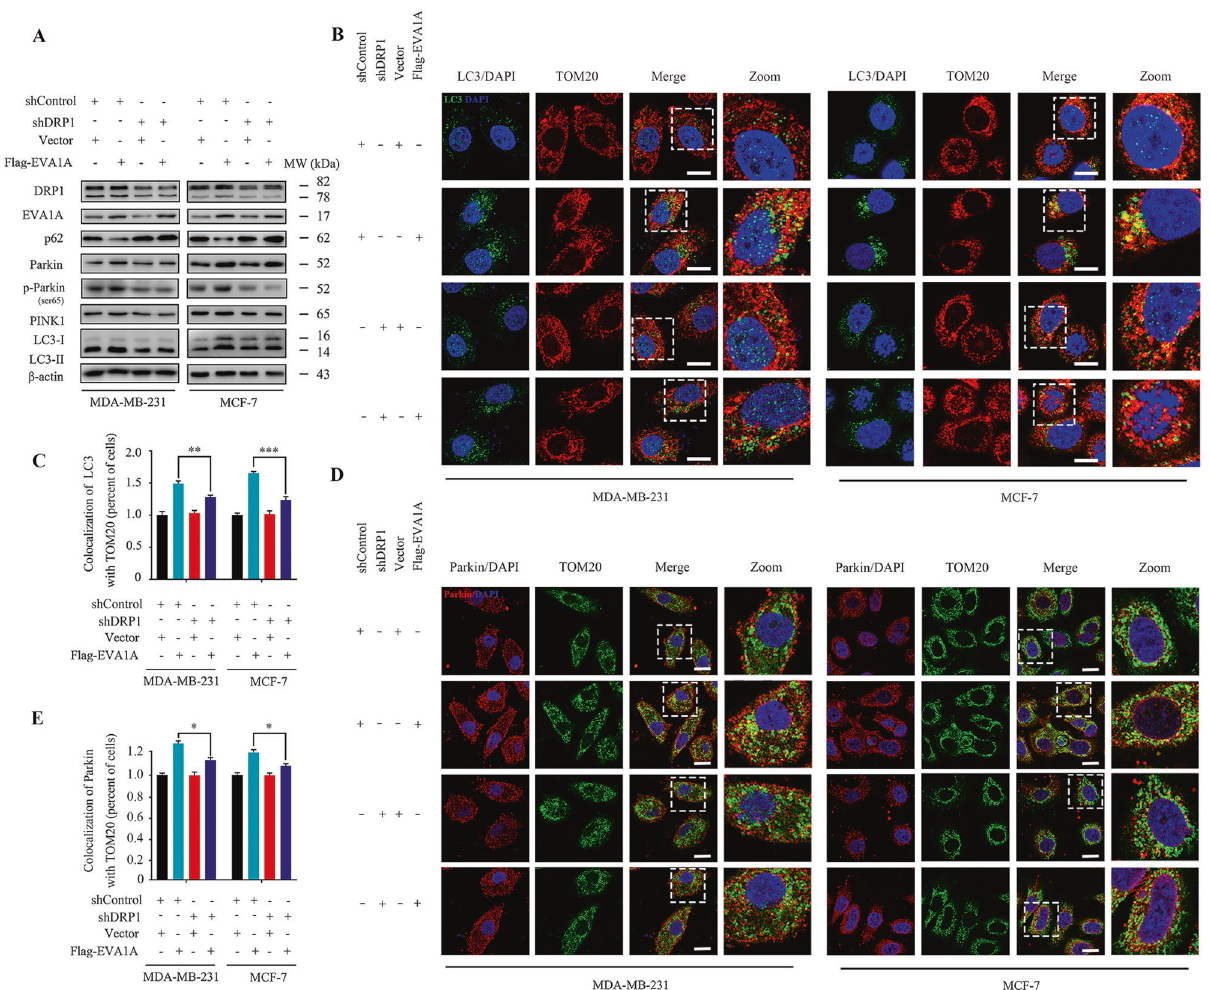
Fig. 7 EVA1A overexpression induces DRP1-mediated mitophagy in MDA-MB-231 and MCF-7 cells. MDA-MB-231 and MCF-7 cells were co- transfected with DRP1 shRNA and Flag-EVA1A or vehicle control respectively for 48 h. A Immunoblotting of DRP1, EVA1A, p62, Parkin, p-Parkin ser65 , PINK1, and LC3 expression. β -actin was measured as the loading control. B , C The autophagosomes are labeled by LC3 (green fl uorescence) protein, and the mitochondria are labeled by TOM20 (red fl uorescence) protein. The number of co-localized LC3 and TOM20 was quanti fi ed. Scale bar, 10 µm. D , E Colocalization of Parkin (red fl uorescence) protein and TOM20 (green fl uorescence) protein in MDA-MB-231 and MCF-7 cells following fl ubendazole (0.5 μ M, 24 h) treatment. The number of co-localized Parkin and TOM20 was quanti fi ed. Scale